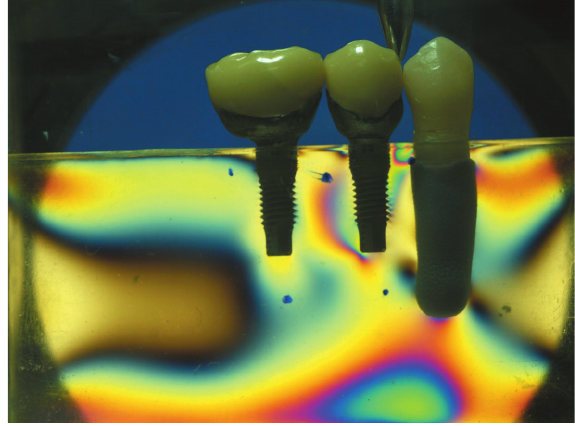
Figure 7- Vertical single point load (5 kgf) on the second premolar (model without the second molar